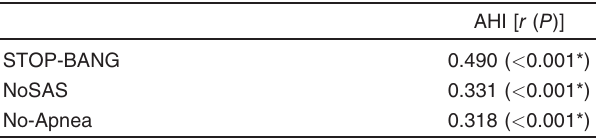
Table 3 Correlation between all the scores studied and severity of sleep-disordered breathing as indexed